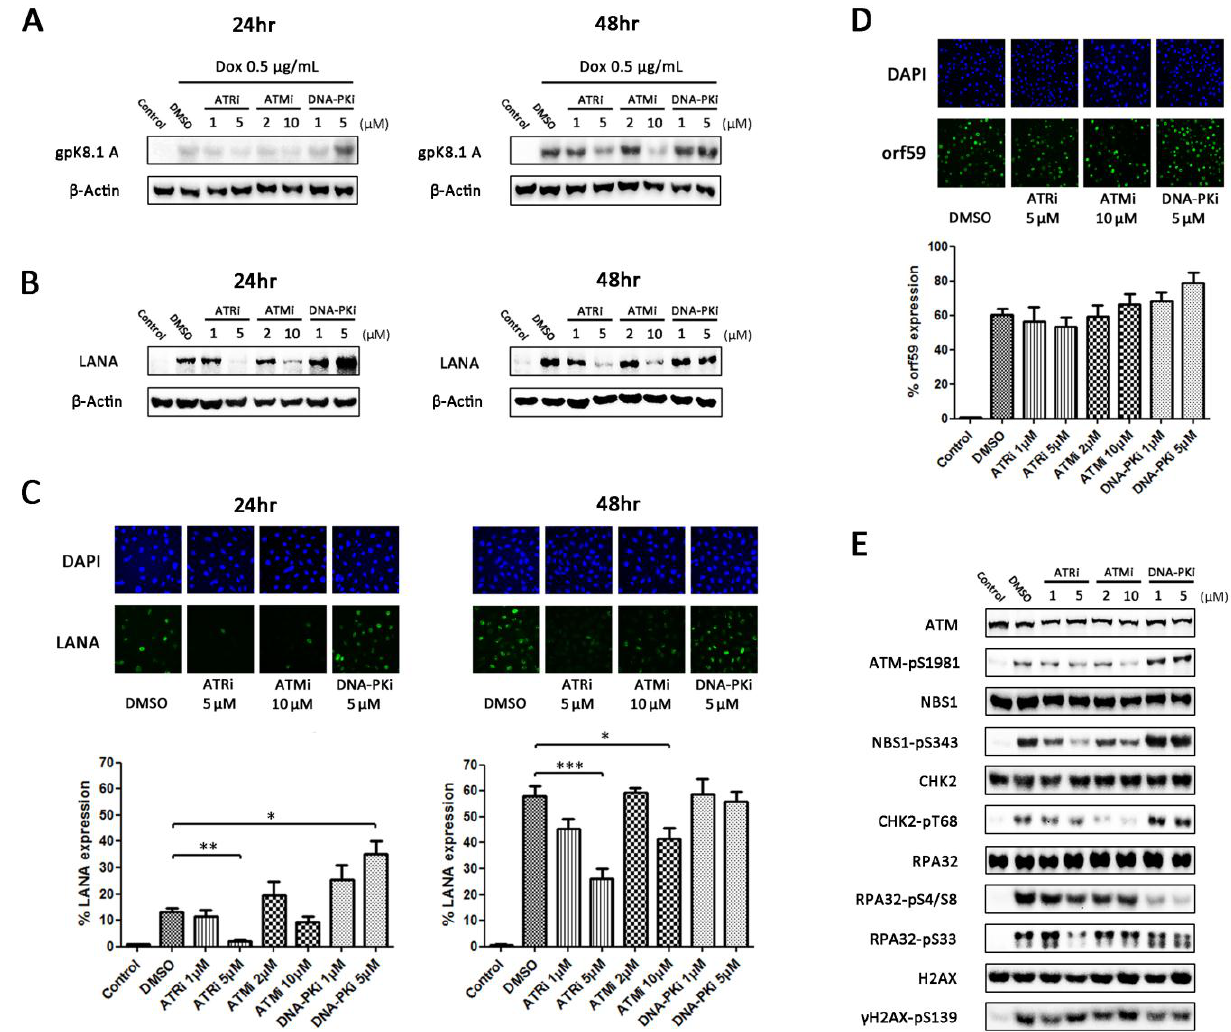
Figure 3. Effect of DDR inhibition on production of infectious virus. ( A ) Expression of late lytic glycoprotein K8.1A in TRE-BCBL-1-RTA cells 24 and 48 h following treatment with DDR kinase inhibitors and doxycycline; ( B ) Expression of LANA in EA.hy926 cells following infection with supernatants collected from TRE-BCBL-1-RTA cells 24 and 48 h after treatment with DDR kinase inhibitors and doxycycline; ( C ) Immunofluorescence microscopy analysis of the percentage of EA.hy926 cells expressing LANA following infection with supernatants collected from TRE-BCBL-1-RTA cells 24 and 48 h after treatment with DDR kinase inhibitors and doxycycline. Each column represents the mean of three independent experiments while the error bars represent the standard error of the mean (SEM). A minimum of 500 cells were analysed for each repetition. * p < 0.05; ** p < 0.01; *** p < 0.001 (statistical analyses were performed using a two-tailed and unpaired Student’s t -test); ( D ) Percentage of TRE-BCBL-1-RTA cells expressing early lytic protein ORF59 24 h following treatment with DDR kinase inhibitors and doxycycline. Each column represents the mean of three independent experiments while the error bars represent the standard error of the mean (SEM). A minimum of 500 cells were analysed for each repetition; ( E ) Levels of phosphorylated DDR proteins in TRE-BCBL-1-RTA cells 24 h following treatment with DDR kinase inhibitors and doxycycline.